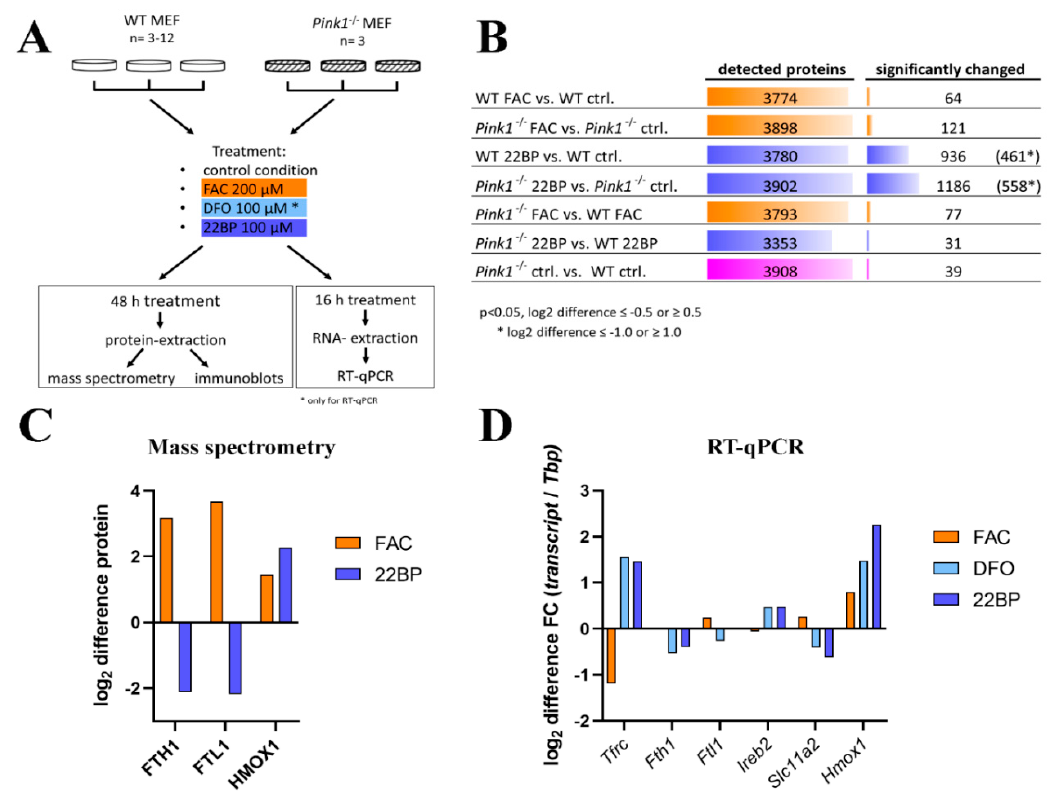
Figure 1. ( A ) Schematic representation of the experimental setup. Wildtype (WT) and Pink1 − / − mouse embryonic fibroblast (MEF) were either left untreated or incubated with ferric ammonium acid (FAC), DFO (Deferoxamine), and 2,2 ′ -Bipyridine (22BP). mRNA expression was analyzed by RT-qPCR after 16 h incubation, while protein abundances were analyzed by mass spectrometry and quantitative immunoblots after 48 h incubation. The FAC treatment is highlighted in orange, whereas the two iron chelator treatments are highlighted in light and dark blue, as the color code for the entire manuscript. ( B ) Summary of mass spectrometry results for the seven conditions studied in comparison, showing the total number of detected proteins and the number of factors with significantly changed abundance, with the respective cutoff values for the significance and the fold-change (shown as log 2 difference). The analysis of WT 22BP versus WT ctrl. and of Pink1 − / − 22BP versus Pink1 − / − ctrl. revealed so many significant factors that a log 2 difference of 1.0 was used as the cutoff for downstream pathway enrichment analyses. ( C ) As measures of quality control for the culture incubations, the fold-changes as log 2 differences are shown for well-established iron homeostasis factors, as detected in mass spectrometry, in comparison to ( D ) the respective log 2 differences by RT-qPCR for such key iron homeostasis genes. The RT-qPCR results were normalized to Tbp expression levels (Tata-binding protein encoding mRNA). ctrl. = untreated control condition.